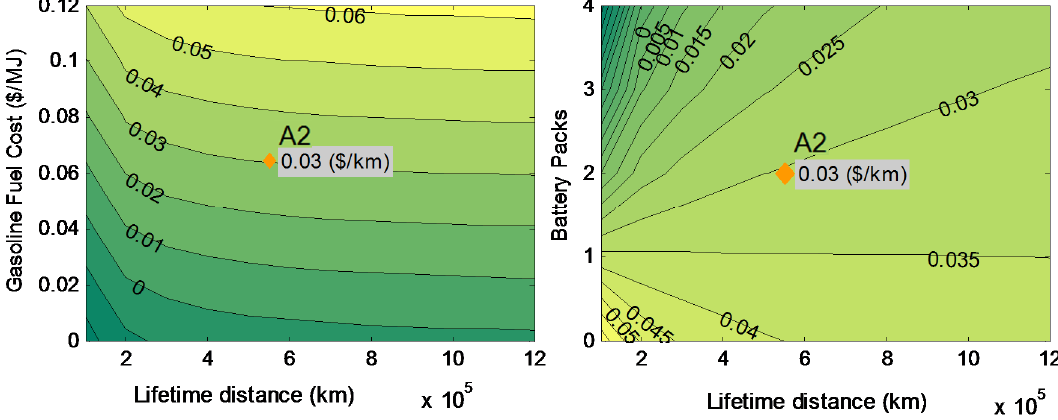
Figure 11. Financial gain considering the gasoline cost and the number of battery packs for the NEDC driving cycle, of optimal solution